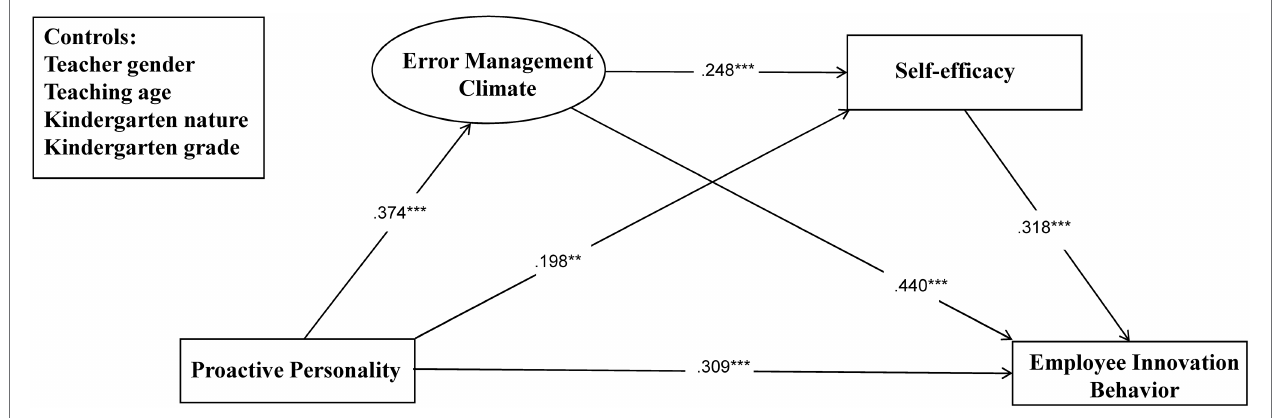
FIGURE 2 | Structural